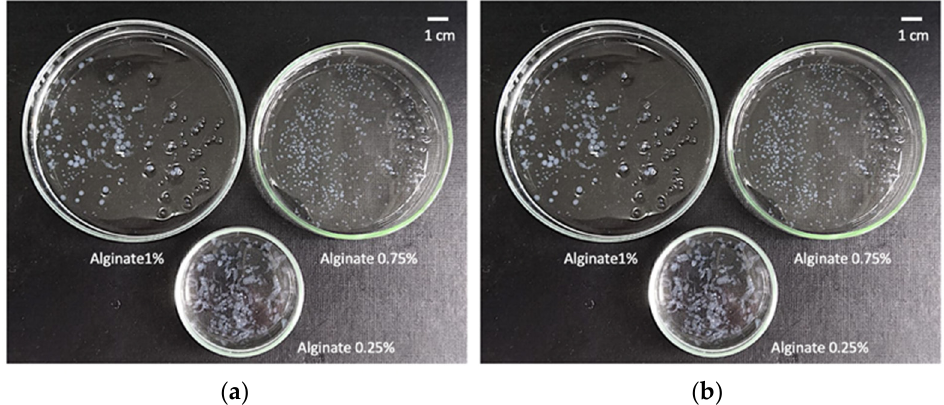
Figure 1. Images of gels from the different alginate concentrations tested for the search of the optimum concentration ( a ) before (hydrogels) and ( b ) after (aerogels) the scCO 2 drying. Drops of 0.75% ( w/v ) alginate solution were printed and gelified using 5 mL CaCl 2